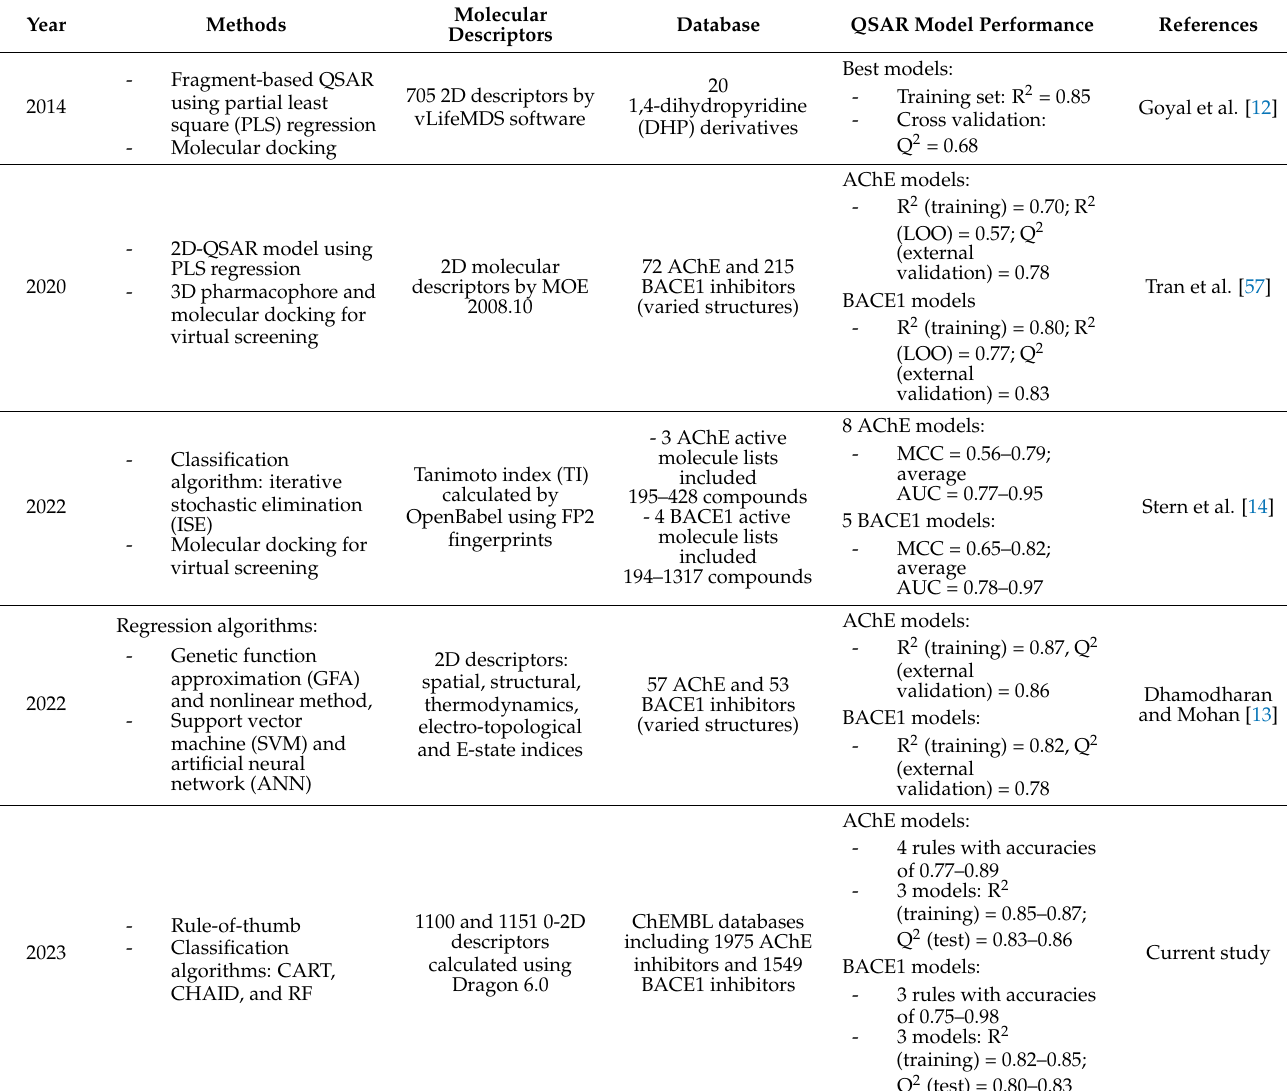
Table 7. Comparison with previous QSAR studies dealing with AChE and BACE1 dual